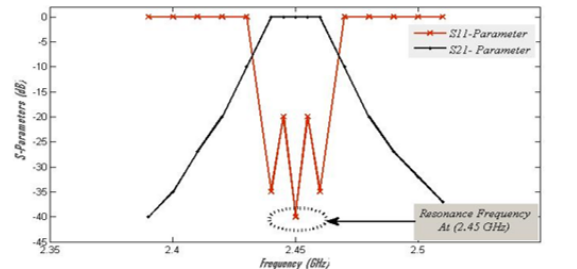
Fig. 8. S-parameter response-curve of the 3 r d - order bandpass filter computing from the above coupling ma-